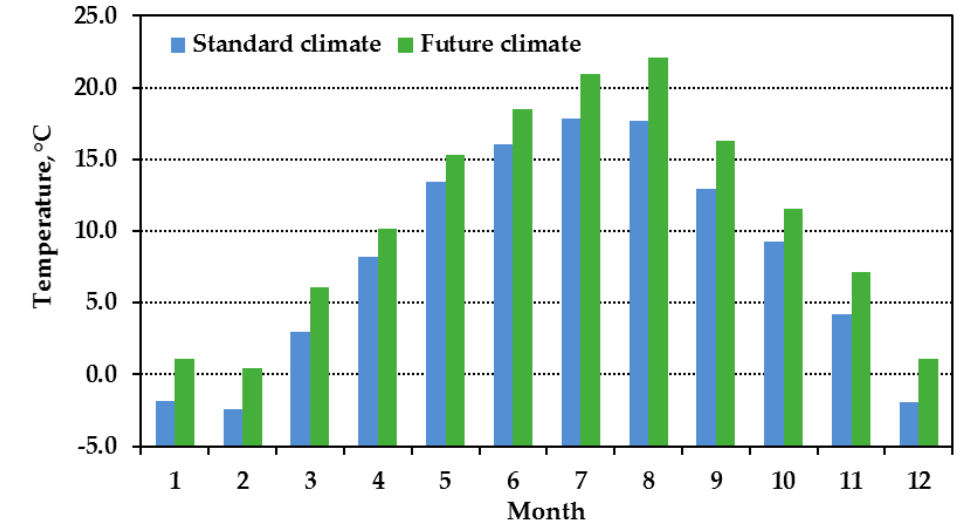
Figure 3. The comparison of average monthly exterior temperature for standard and future climate.